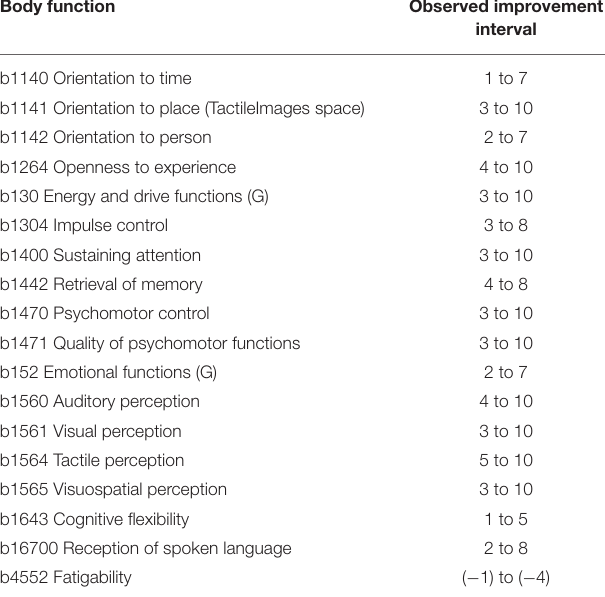
TABLE 2 | Body functions